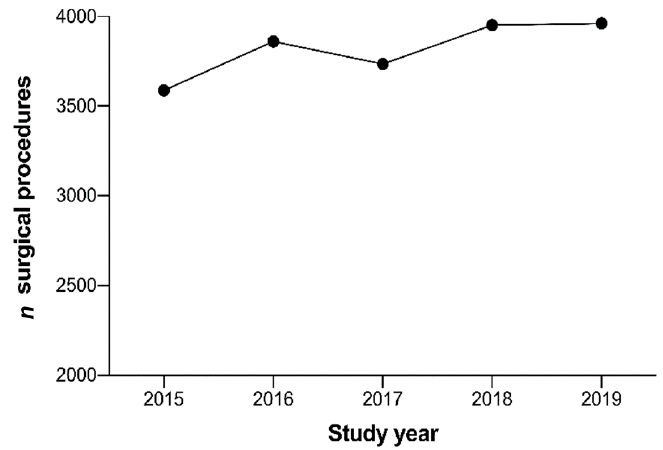
Figure 1. Number of surgical procedures in the study years 2015 – 2019. Table 1. Surgical complications stratified by study years.